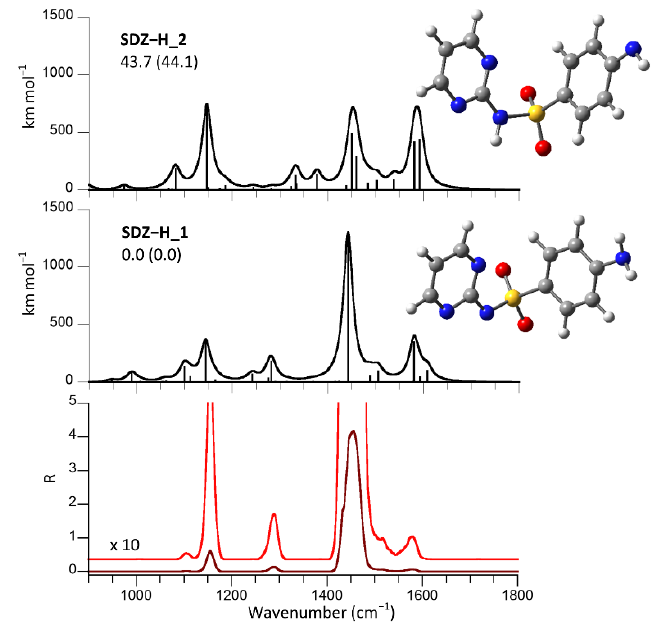
Figure 1. IRMPD spectrum of (SDZ − H) − (bottom panel, dark and pale red profiles) compared with calculated IR spectra of SDZ − H_1 and SDZ − H_2 , the optimized structures of which are reported on the right. Relative free energies (enthalpies) at 298 K are reported in kJ mol − 1 . Calculations are at the B3LYP/6-311+G(2df,pd) (S = 6-311+G(3df)) level. Computed harmonic frequencies are scaled by a factor of 0.974, except those regarding S-X stretching modes, which are left